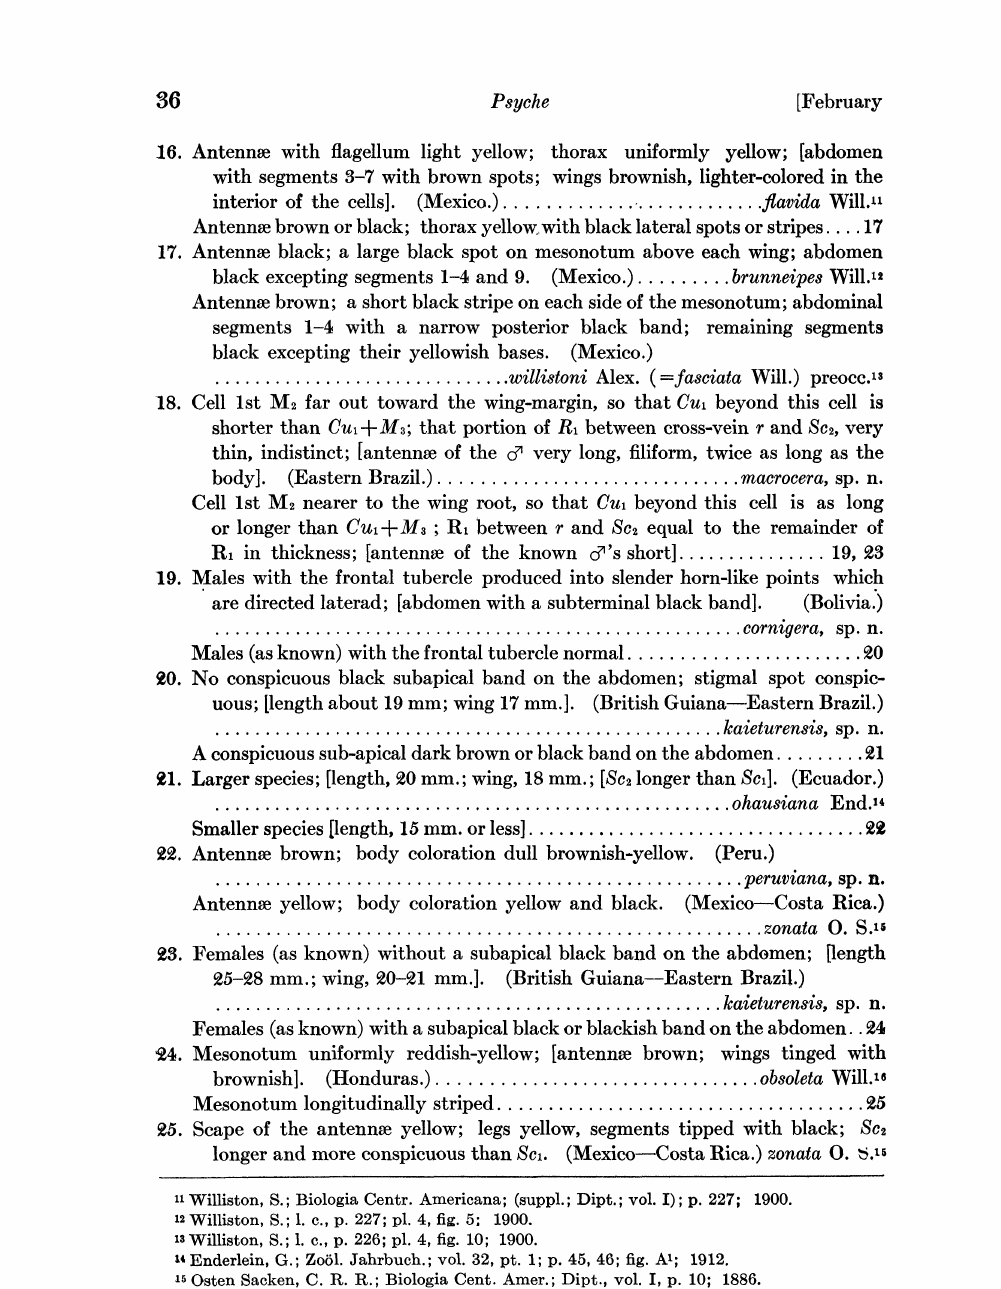
Psyche [February 16. Antennae with flagellum light yellow; thorax uniformly yellow; [abdomen with segments 3-7 with brown spots; wings brownish, lighter-colored in the interior of the cells]. (Mexico.) flavida Will.,t Antennae brown or black" thorax yellow,, with black lateral spots or stripes 17 17. Antennae black; a large black spot on mesonotum above each wing; abdomen black excepting segments 1-4 and 9.